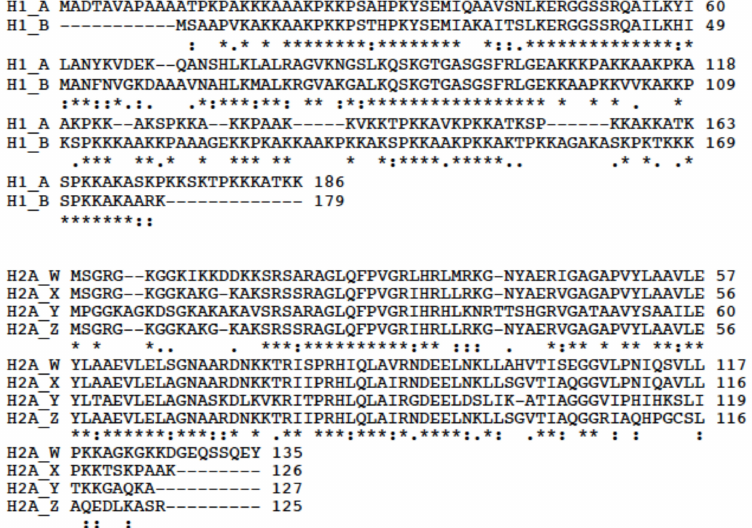
Figure 3. Multiple Alignments of the two Lucina pectinata H1 and the four H2A amino acid sequences. These alignments were generated using cluster analysis of the pairwise alignments with the CLUSTAL Omega tool available at https://www.uniprot.org/align/.